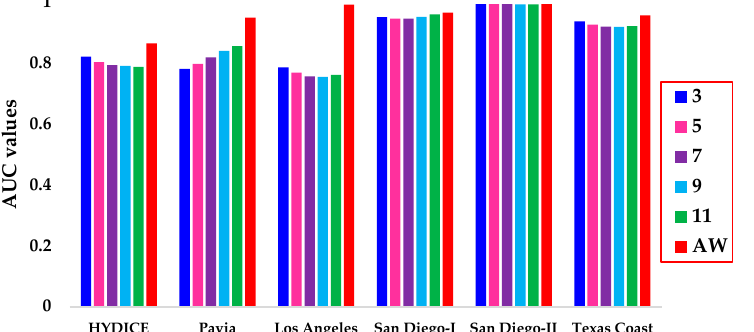
Figure 10. Histogram of the comparison results between the adaptive inner window–based method and dual rectangular windows–based method on experimental datasets. Here, “3”, “5”, “7”, “9” and “11” represent the size of inner window in dual rectangular windows, “AW” denotes the adaptive inner window.